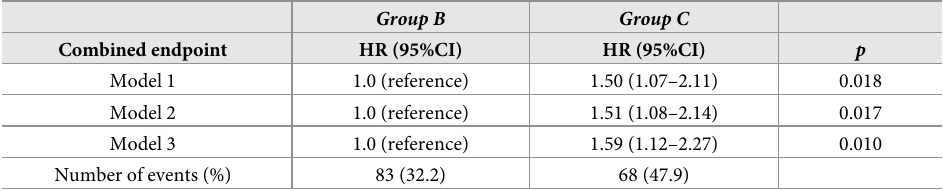
Table 3. Risk of all-cause mortality and progression to end-stage kidney